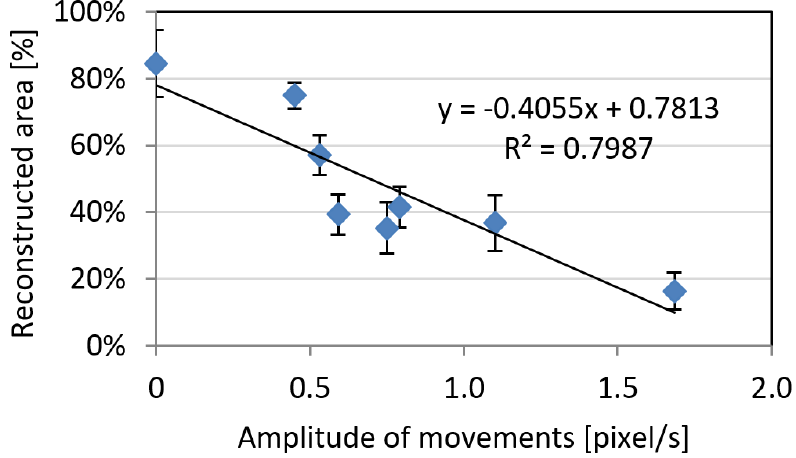
Figure 6. The reconstructed area rate as a function of average estimated animal movements’ amplitude. Error bars represent standard deviation on three different reconstructions.